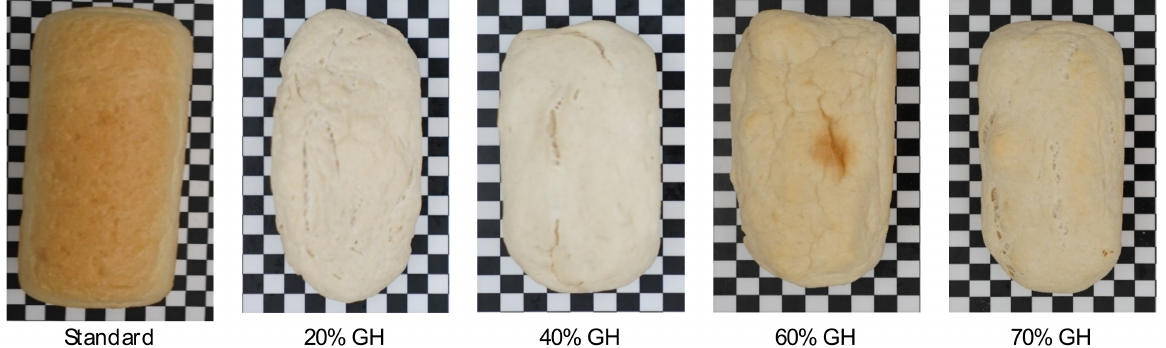
Figure 1. Pictures of standard and GH breads with promoters (20–70%). The pictures show the variation in the bread prepared with GH when promoters are used in different percentages and a comparative evaluation of the color on the crust of the bread with respect to standard bread.